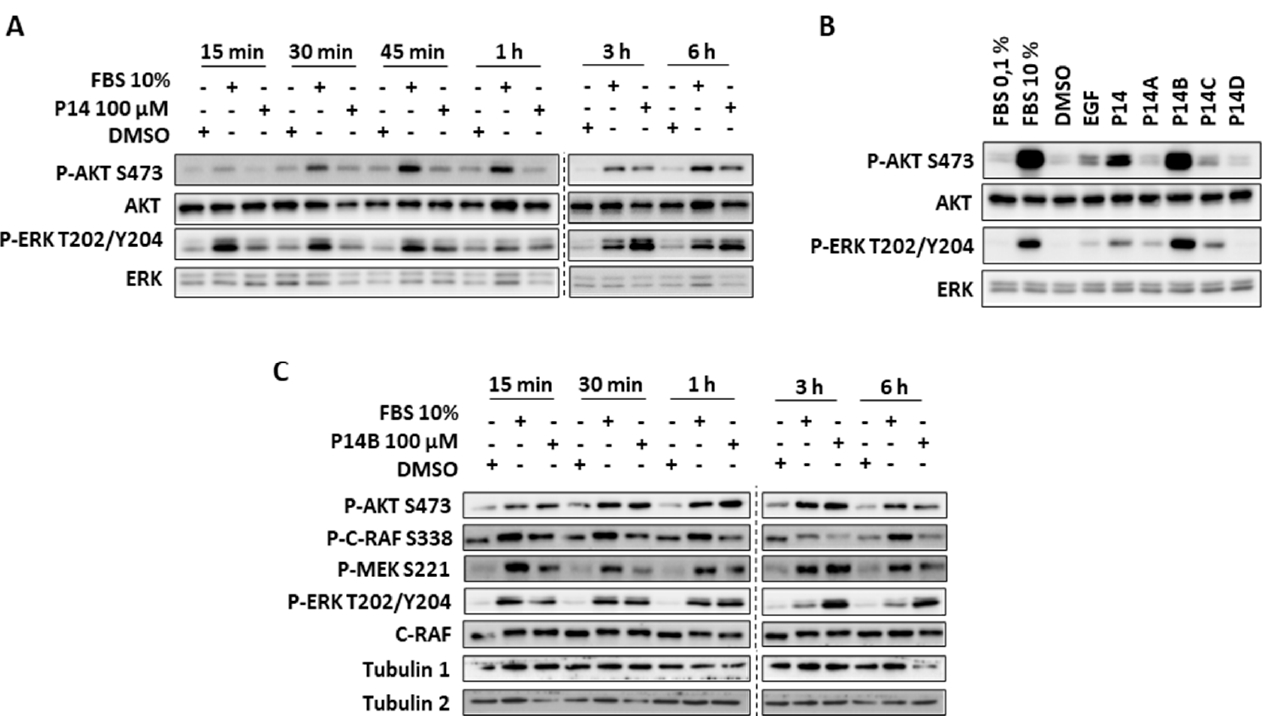
Figure 2. P14 and P14B treatment of DLD-1 cells increased endogenous downstream RAS signaling. ( A ) DLD-1-starved cells were incubated for different times with 100 µM P14, or for 30 min with 10% FBS. ( B ) DLD-1 starved cells were incubated for 3 h with 100 µM P14, P14A, P14B, P14C or P14D, or for 30 min with 10% FBS, or for 10 min with 50 ng/mL of EGF. ( C ) DLD-1 starved cells were incubated for different times with either 10% FBS or 100µM P14B. ( A ), ( B ) and ( C ) The levels of activation and the total levels of RAF, MERK, ERK and AKT were analyzed by WB with specific these proteins, respectively. In ( C ), tubulin was used as loading control. Tubulin 1 corresponds